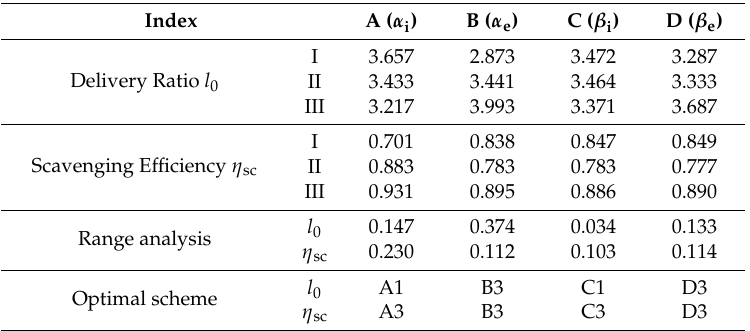
Table 4. Range analysis.